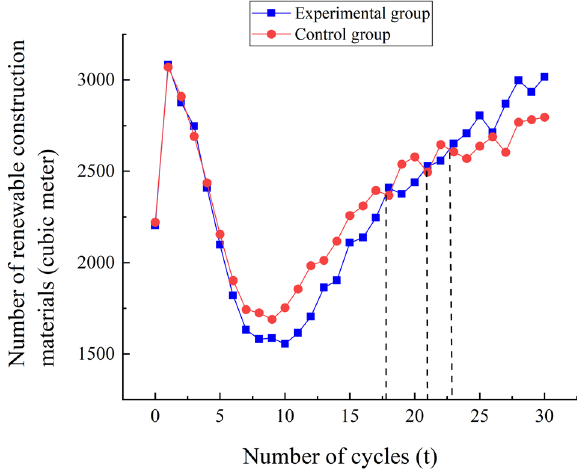
Fig. 5 The process of the in fl uence of changing the percentage of construction enterprises adopting green development behaviors on the renewable construction materials market. The moments marked by dashed lines in the graph represent the same amount of renewable construction materials generated under different scenarios.